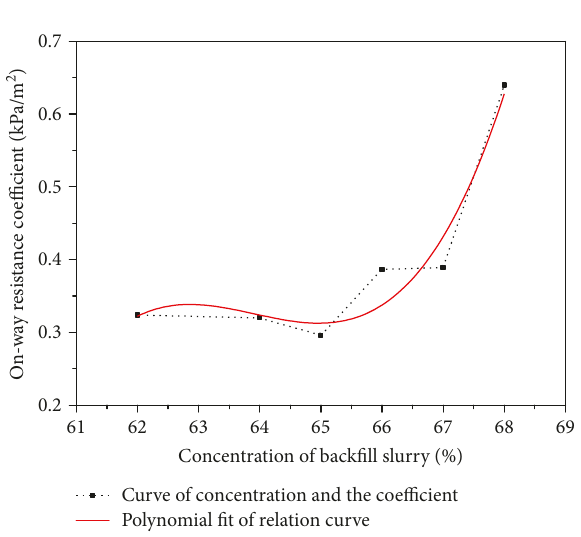
Figure 13: Relation curve of on-way resistance coe ffi cient and slurry concentration.